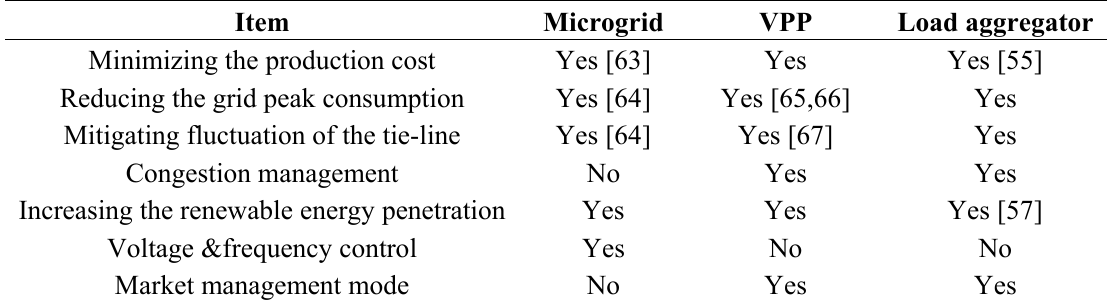
Table 2. Summary of the management effectiveness of broad controllable